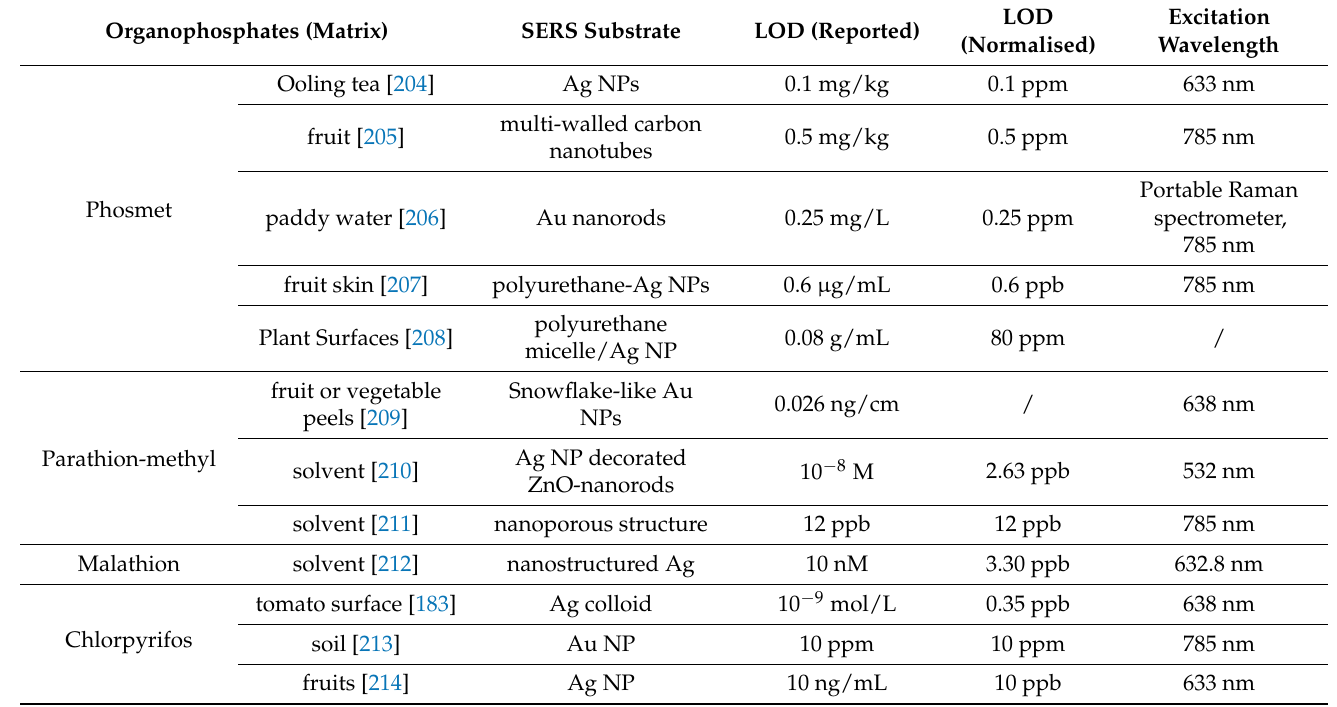
Table 2. Organophosphates (OP) detection by SERS in food industry and environment monitoring. Organophosphates (Matrix) SERS